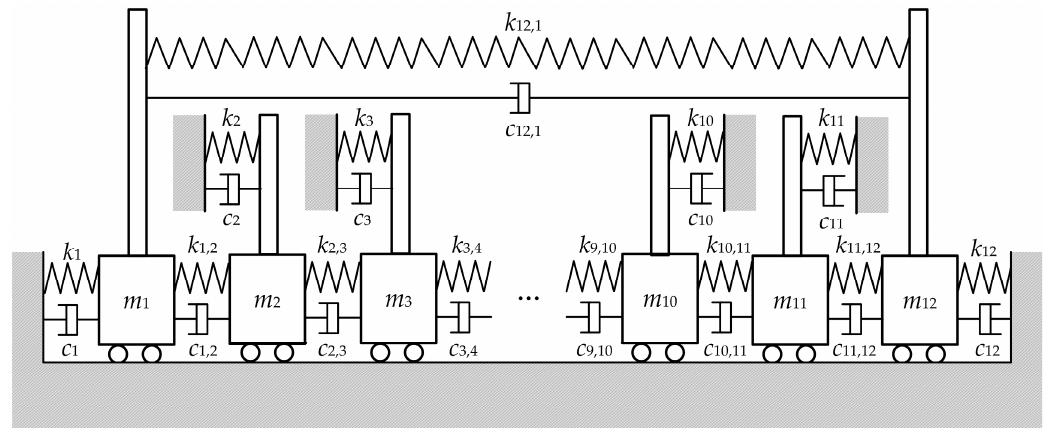
Figure 3. The simulated model. m i , k i , and c i ( i = 1, 2, 3... 12) represent the mass, stiffness, and damping coefficient of blade i , respectively. k i, j and c i, j (| i - j | = 1) represent the coupling stiffness and coupling damping coefficient between adjacent blades.